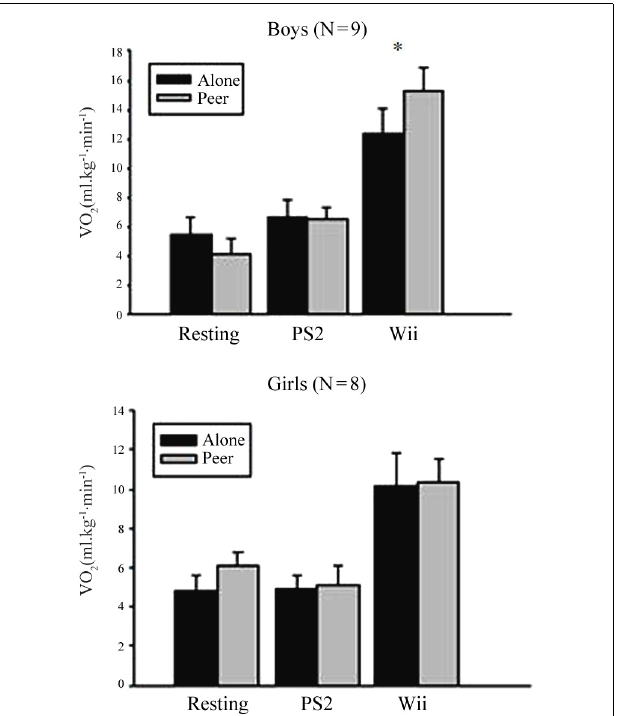
FIGURE 1 | VO 2 for social condition by gaming condition by sex: mean ± s.e.m. for social condition by gaming condition by sex interaction for VO 2 . In the peer condition males had significantly greater ( p = 0 . 02) increase ( (cid:2) 11 . 1 ± 5 . 3mlkg − 1 min − 1 ) in VO 2 from rest to “exer game” (Wii™) versus the alone condition ( (cid:2) 6 . 8 ± 3 . 1mlkg − 1 min − 1 ), ( upper panel ). Females showed no significant change ( p ≥ 0 . 44) from alone to peer for any gaming conditions ( lower panel ). PS2, Playstation 2™ (sedentary